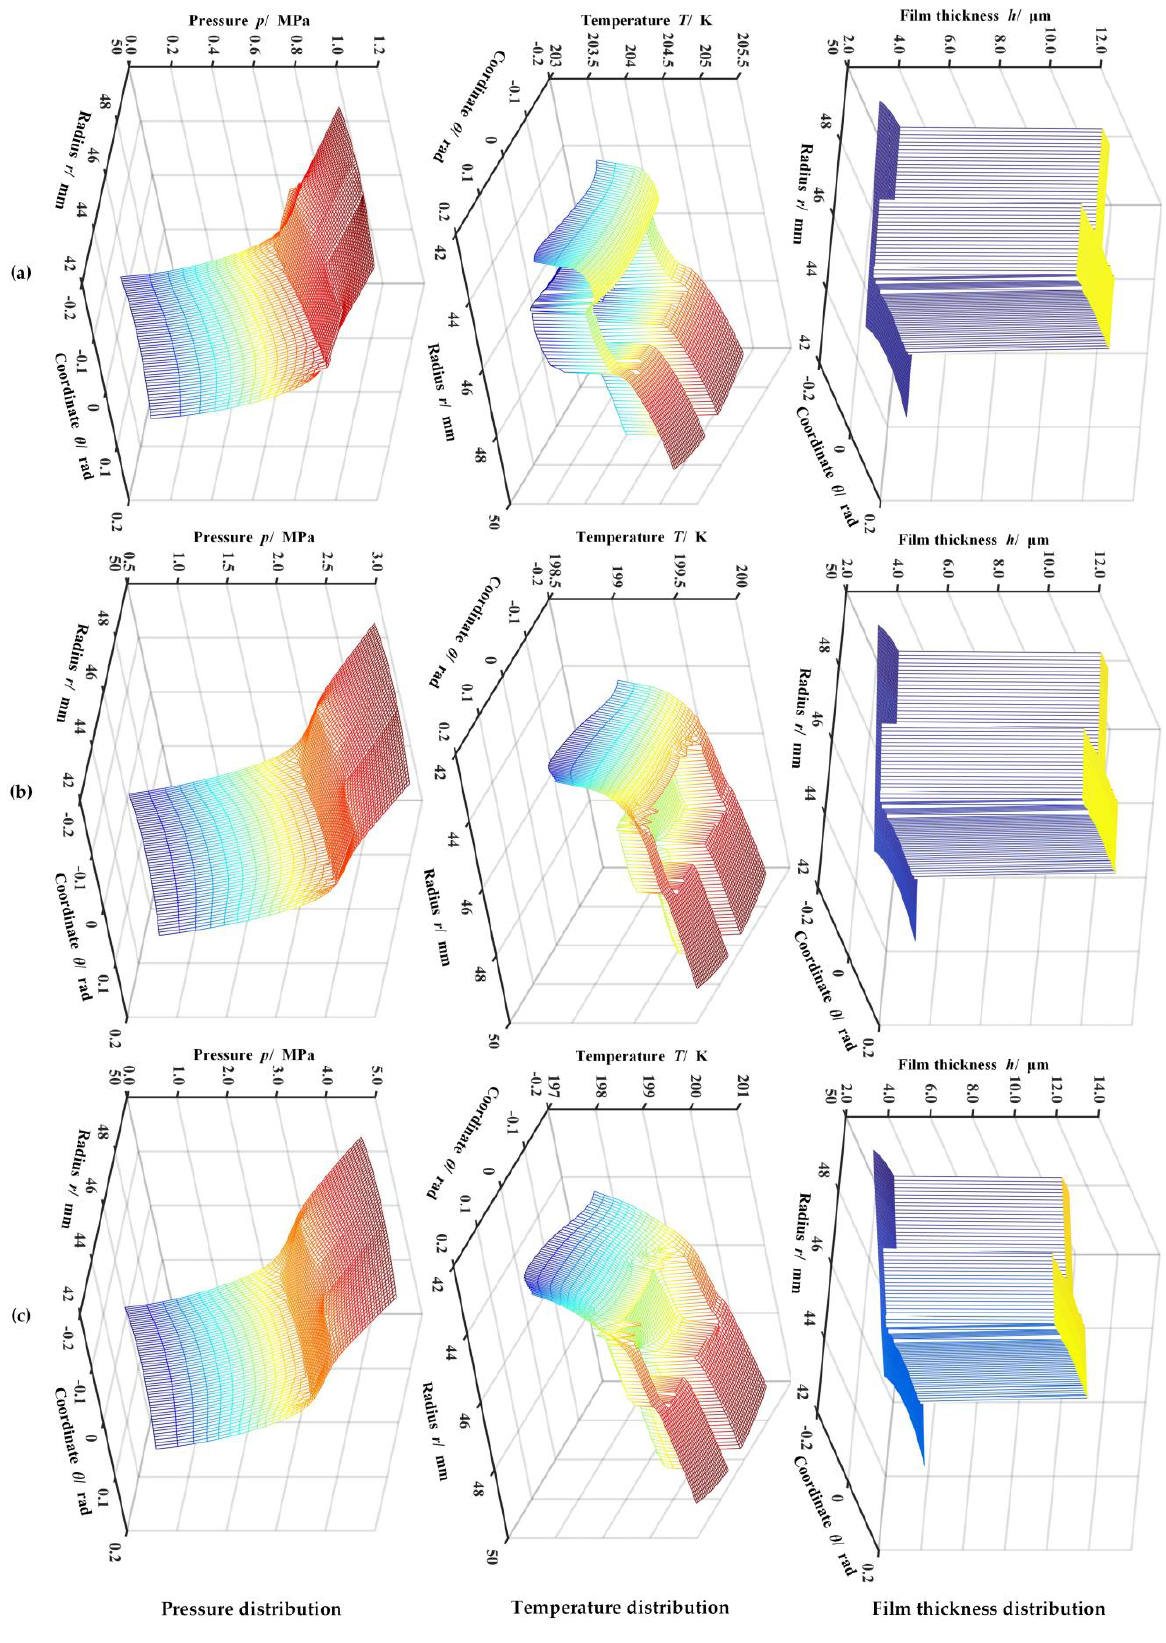
Figure 5. Variation of the pressure, temperature, and film thickness distribution of helium gas face seal with different inlet ambient pressure ( h 0 = 3.0 μm, ω = 20,000 r·min −1 , T o = 200 K). Note: ( a ) p o = 1.0 MPa; ( b ) p o = 3.0 MPa; ( c ) p o = 5.0 MPa.